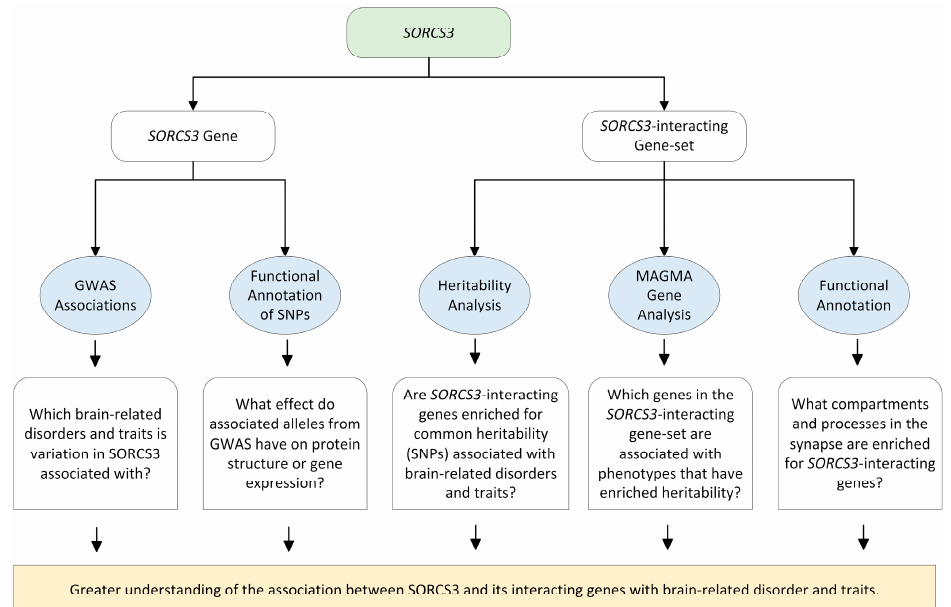
Figure 1. Workflow of the study design employed to ask multiple research questions related to SORCS3 ′ s association with brain-related disorders and traits.